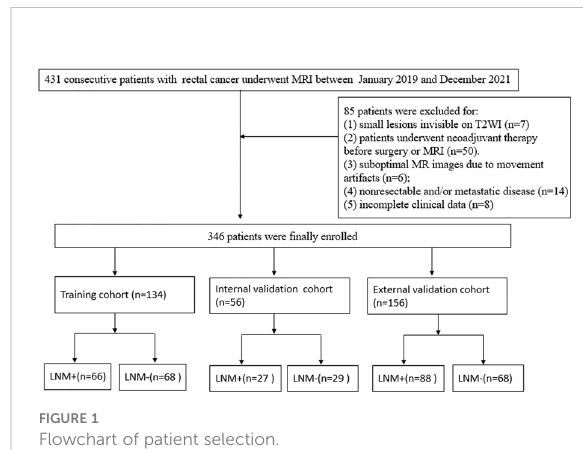
FIGURE 1 Flowchart of patient